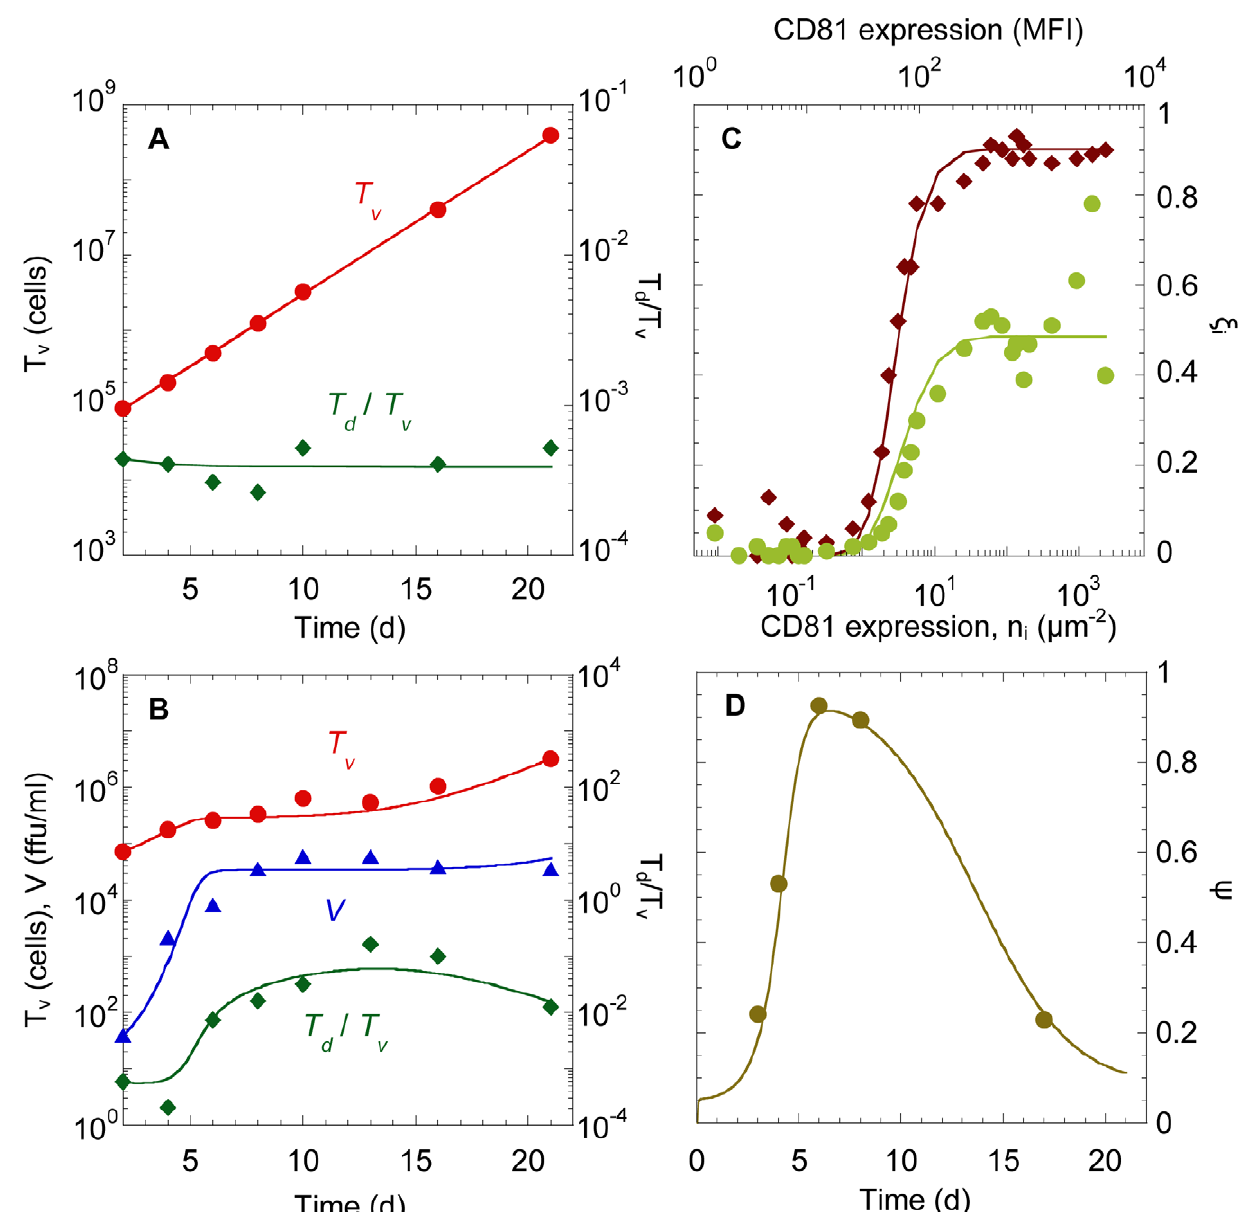
Figure 3. Comparisons with experiments. (A) Fits of model predictions (lines) to data [15] (symbols) of the time-evolution of the population of viable cells, T v , and the ratio of the populations of dead and viable cells, T d = T v , in the absence of infection using l and m as adjustable parameters. Initial conditions: T (2) ~ 9 | 10 4 cells and T d (2) ~ 40 cells . (B) Fits of model predictions (lines) to data (symbols) [15] of the time-evolution of T v , T d = T v , as adjustable parameters and with K D ~ 1 : 7 | 10 { 4 M . Initial conditions: V (2) ~ 40ffu : ml { 1 ; and the viral titre, V , using d , b , v ( ~ p = c ) , and N T C I (2) ~ v V (2) ; T (2) ~ 9 | 10 4 { I (2) cells ; T d (2) ~ 40 cells . (C) Fits of model predictions (lines) of fractions of cells infected in sub-populations with , p and b as adjustable parameters and with distinct CD81 expression levels, j i , at day 3 post-infection to data [13] (symbols) using N T C K D ~ 1 : 7 | 10 { 4 M . Initial conditions: T (0) ~ 10 5 cells ; I (0) ~ 0 ; V (0) ~ 10 5 TCID 50 (MOI , 1; circles) or 5 | 10 5 TCID 50 (MOI , 5; diamonds). Fits with other values of